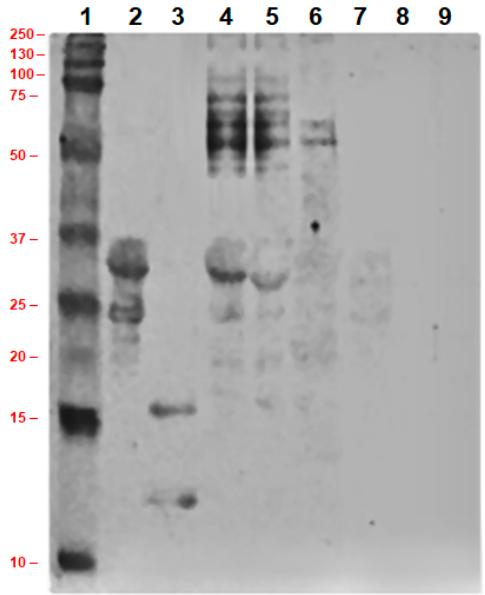
Figure 10. Immunoblot of ultra-heat-treated skimmed milk, milk with concentrated proteins and milk with concentrated proteins after enzyme treatment; lane 1: marker protein, lane 2: standard casein, lane 3: standard α -lactalbumin and β -lactoglobulin, lane 4: ultra-heat-treated skimmed milk, lane 5: concentrated ultra-heat-treated skimmed milk, lane 6: concentrated liquid milk protein treated with 0.008 g·L − 1 of trypsin, lane 7: concentrated liquid milk protein treated with 0.016 g·L − 1 of trypsin, lane 8: concentrated liquid milk protein treated with 0.032 g·L − 1 of trypsin, lane 9: concentrated liquid milk protein treated with 0.064 g·L − 1 of trypsin.